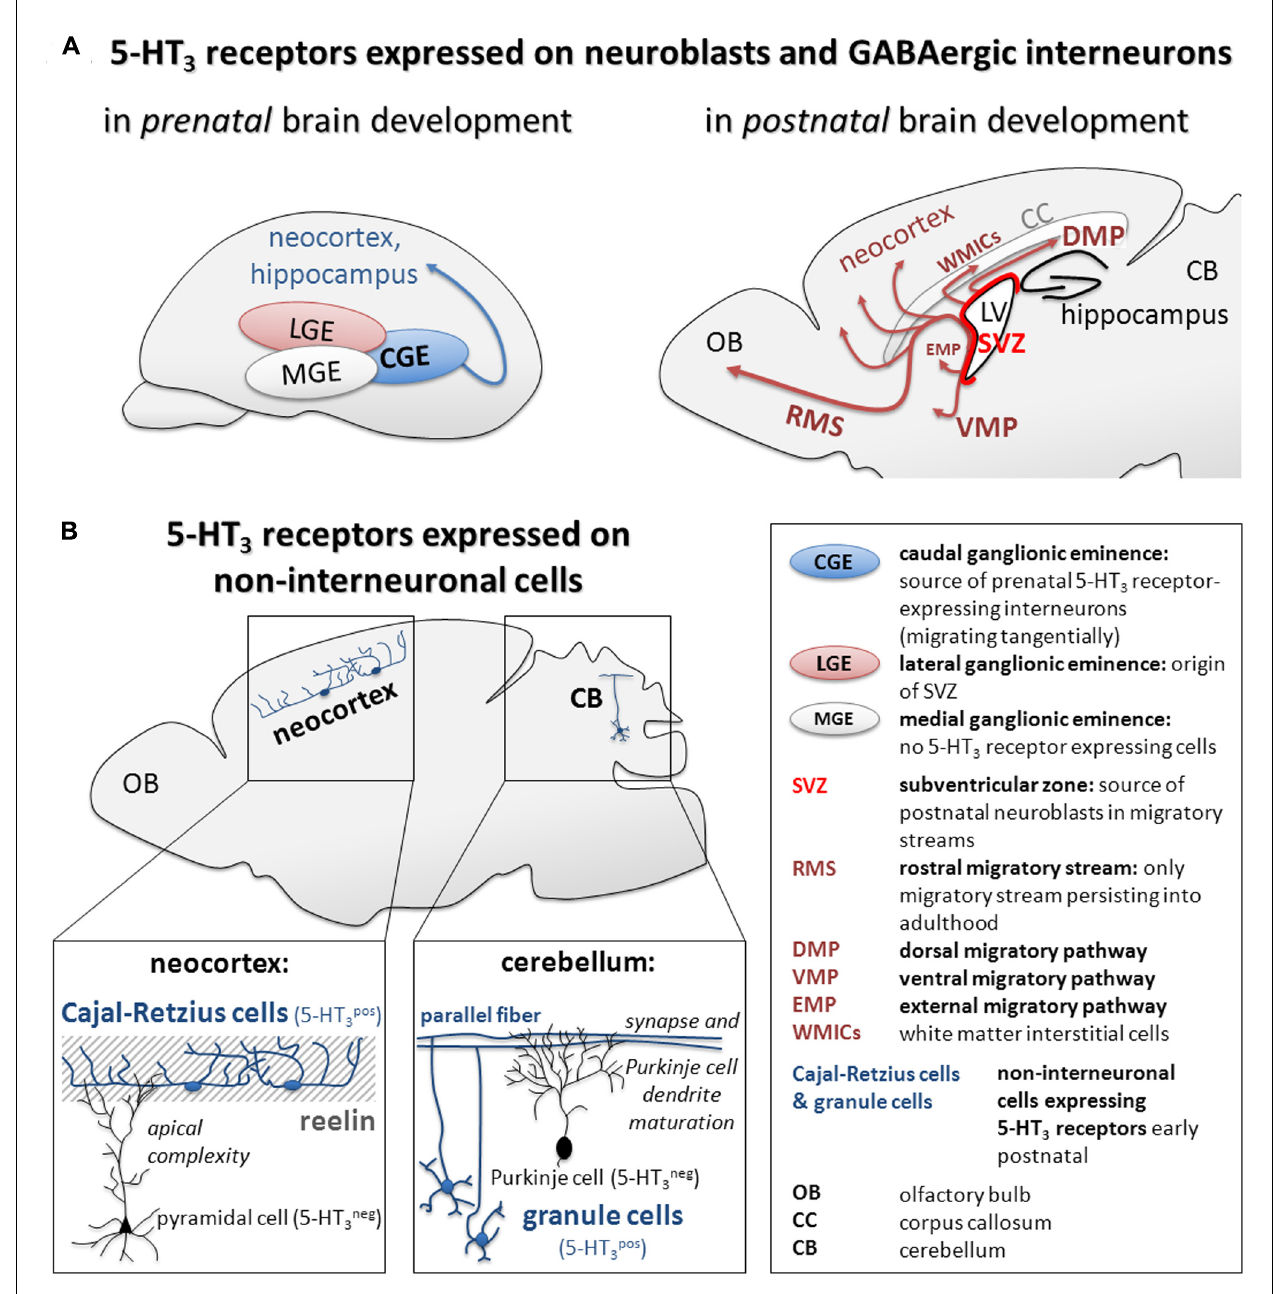
FIGURE 1 | Summary of (A) 5-HT 3 receptor expression on GABAergic interneurons during pre- and postnatal brain development and (B) recently described mechanisms of 5-HT 3 receptor-mediated regulation of maturation of cortical pyramidal cells and cerebellar Purkinje cells in the early postnatal